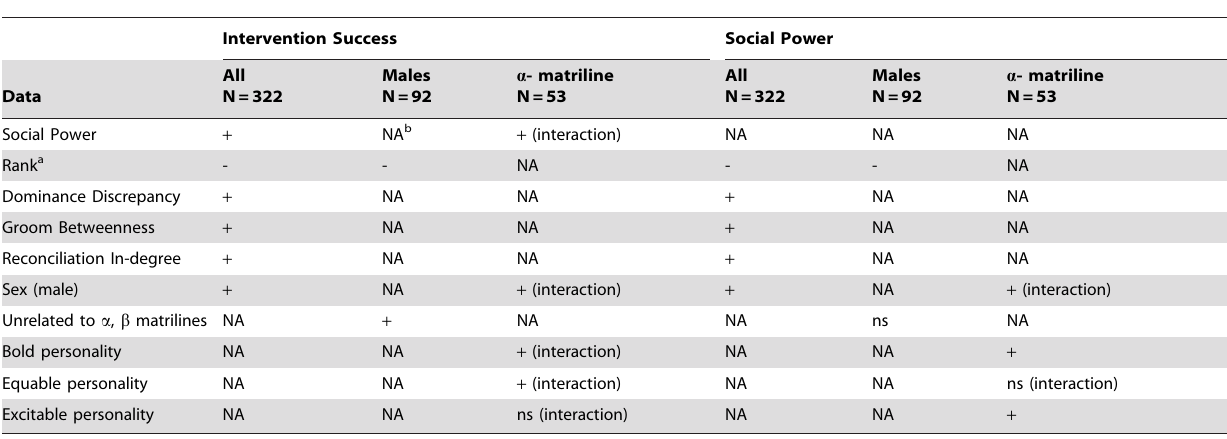
Table 3. Individual-level